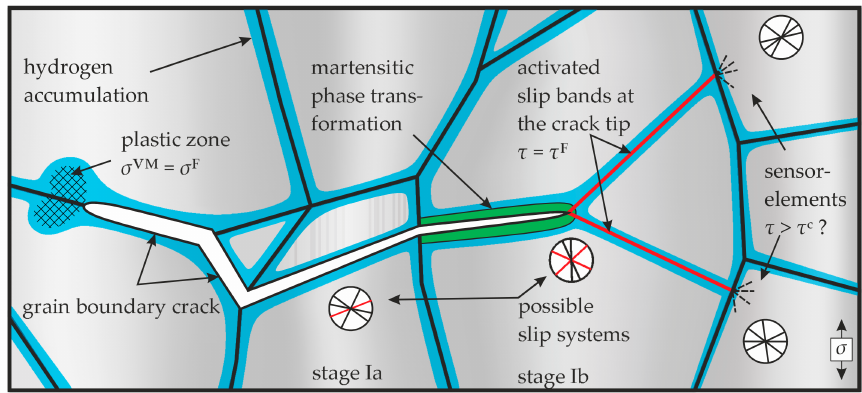
Figure 5. Schematic of the short crack growth